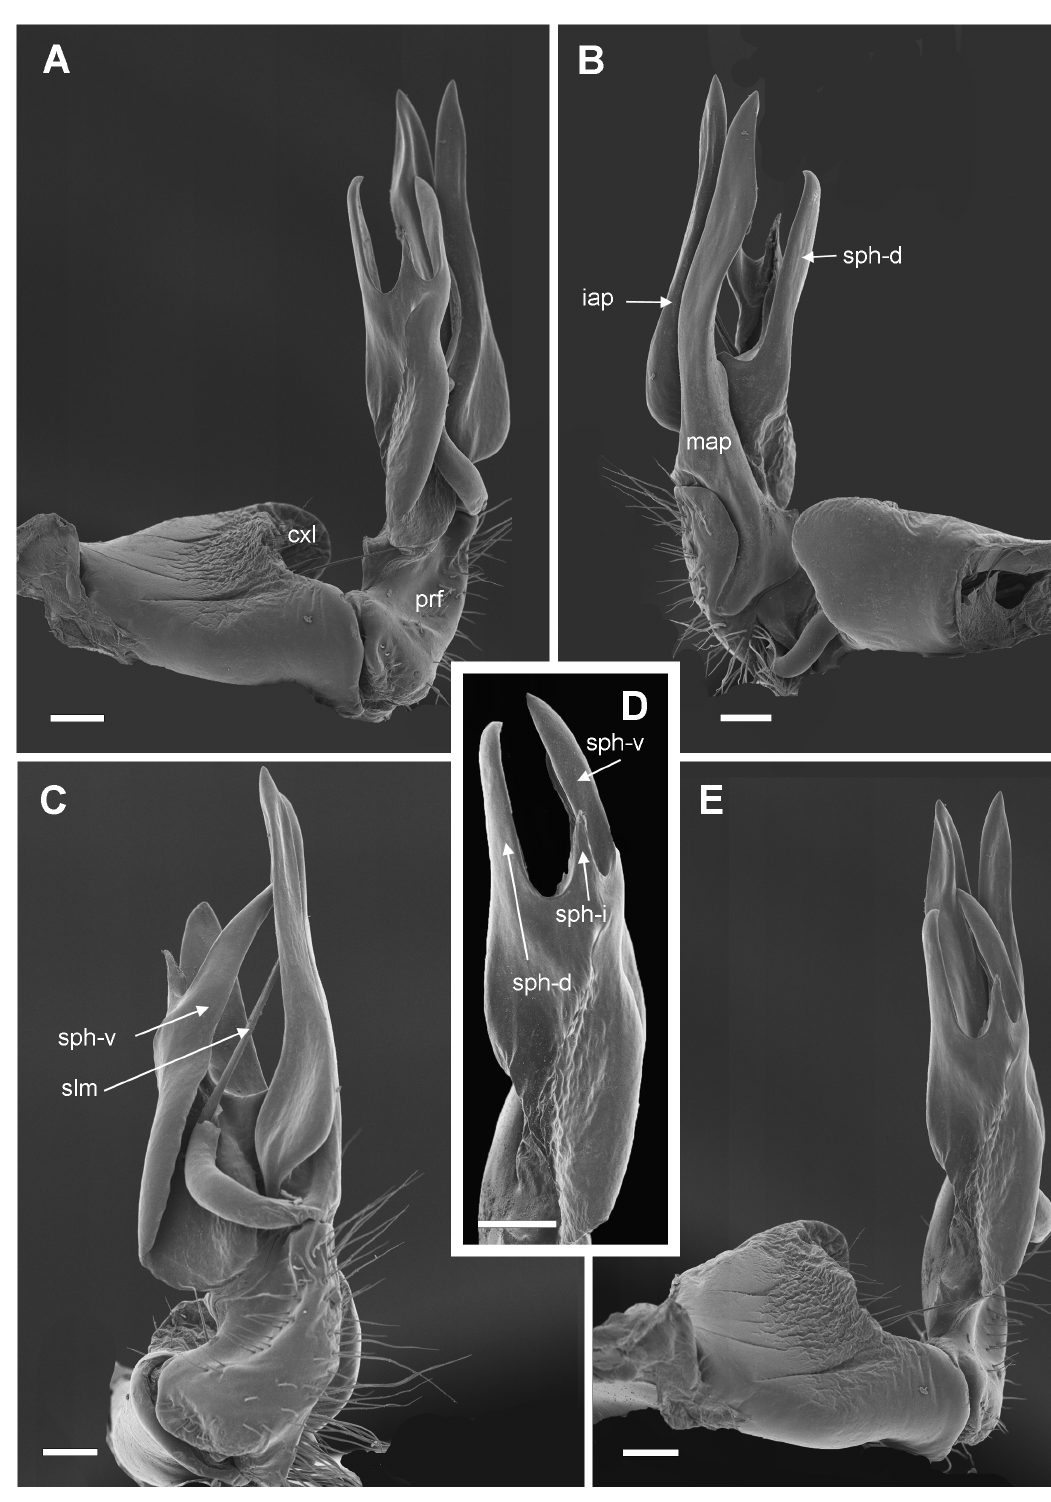
Fig. 15. Eviulisoma commelina sp. nov., holotype, right gonopod. A . Lateral view. B . Mesal view. C . Ventral view. D . Solenophore, dorso-lateral view. E . Dorso-lateral view. Abbreviations: cxl = coxal lobe; iap = intermediate acropodital process; map = mesal acropodital process; prf = prefemoral part; slm = solenomere; sph-d , sph-i , sph-v = dorsal, intermediate and ventral lobes of solenophore. Scale bars: 0.1